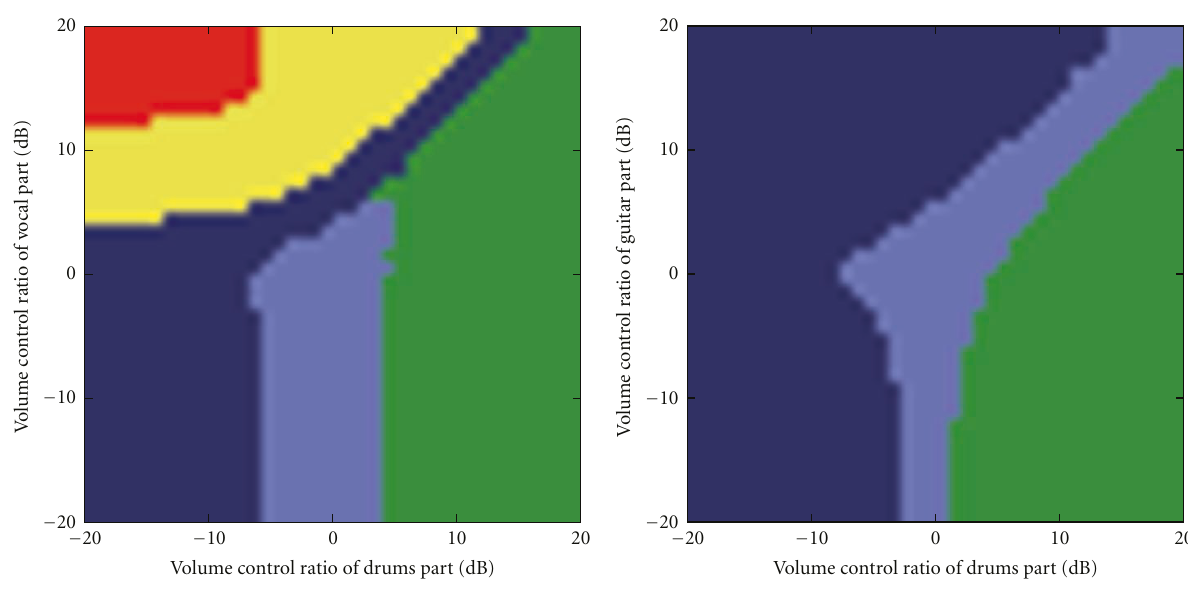
Figure 7: Genres that have the smallest EMD (the highest similarity) while reducing or boosting the volume of two instrument parts. (a), (b), and (c) are the cases of the vocal-guitar, vocal-drums, and guitar-drums, respectively. (a) Genre classification shift caused by changing the volume of vocal and guitar. (b) Genre classification shift caused by changing the volume of vocal and drums. (c) Genre classification shift caused by changing the volume of guitar and